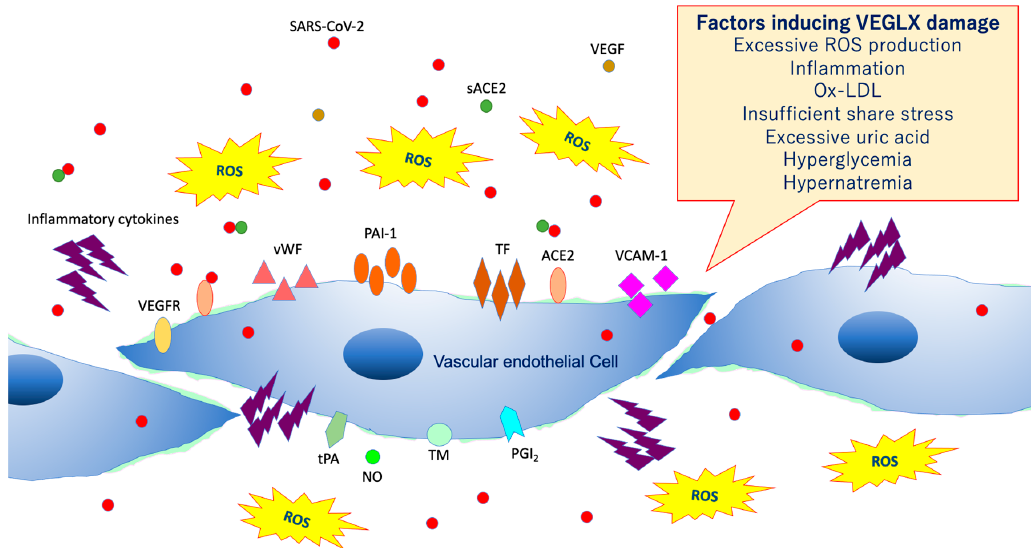
Figure 8. Damaged vascular endothelial glycocalyx (VEGLX). VEGLX damage is associated with vascular endothelial dysfunction, which induces reduced nitric oxide (NO) bioavailability, increased excessive reactive oxygen species (ROS) production, inflammatory cytokine release, platelet adherence, coagulation, and leukocyte adhesion. SARS-CoV-2, severe acute respiratory coronavirus 2; VEGF, vascular endothelial growth factor; VEGFR, VEGF receptor; ACE2, angiotensin-converting enzyme 2; sACE2, soluble ACE2; PAI-1, plasminogen activator inhibitor-1; TF, tissue factor; vWF, von Willebrand factor; ox-LDL, oxidized low-density lipoprotein; MMPs, matrix metalloproteases; tPA, tissue plasminogen activator; PGI2, prostacyclin; TM, thrombomodulin.